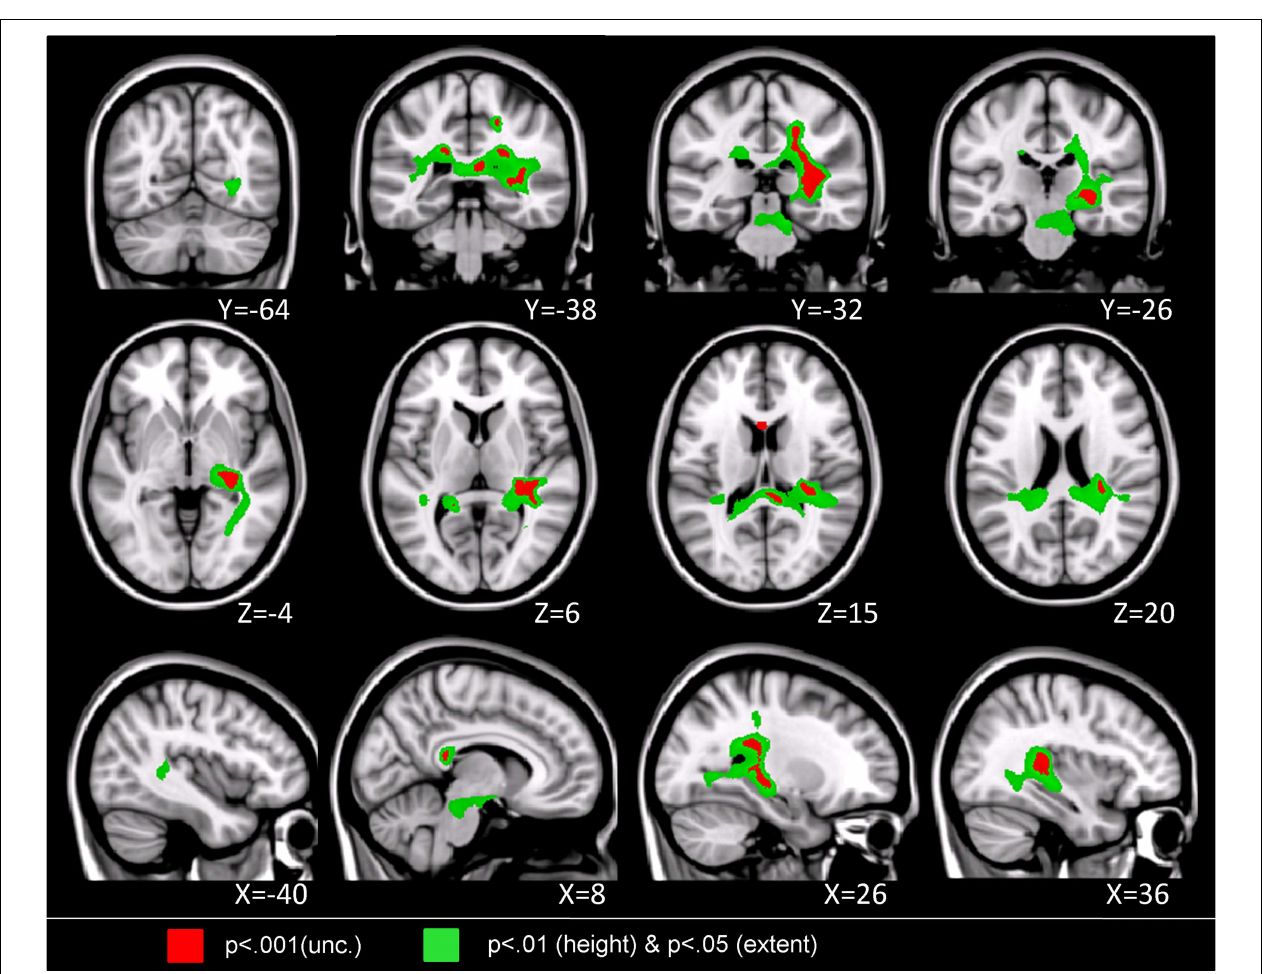
FIGURE 2 | Brain regions where children with DD showed signifi cant white matter defi cits, compared to TD children (two-sample t -test results for TD > DD contrast). Red: p < 0.001; Green: height threshold p < 0.01, extent threshold p < 0.05 with family-wise error correction for multiple comparisons and correction for non-isotropic smoothness.